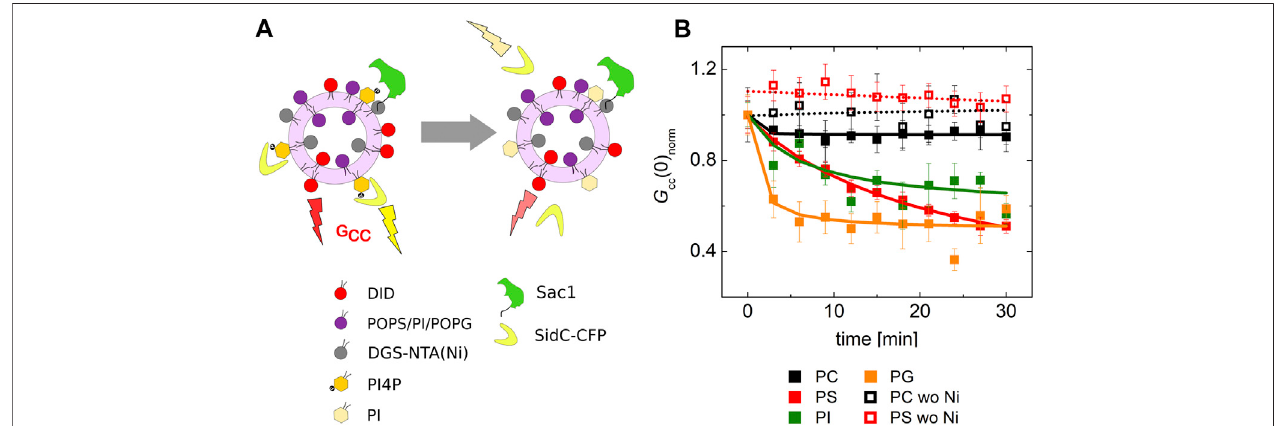
FIGURE4 | PI4P dephosphorylation by Sac1 followed byFCCS. (A) Schematics of the FCCS experiment. (B) Temporal evolution of the normalized G cc amplitude referring on the SidC-CFP release (PI4P dephosphorylation) from the membranes of LUVs. The membrane where the reaction was followed was composed of POPC (black squares), POPC/PS (20 mol% of PS) (red squares), POPC/PI (20 mol% of PI) (green squares), and POPC/PG (20 mol% of PG) (orange squares). The membrane either contained DGS-NTA(Ni) for Sac1 attachment through His-tag (solid squares), or DGS-NTA(Ni) was omitted and Sac1 remained in the solution (empty squares). The amount of PI4P in all the examined membranes was 0.1 mol%. The error bars stand for the standard deviation. The presented data represent the trends that were observed in minimum three independent